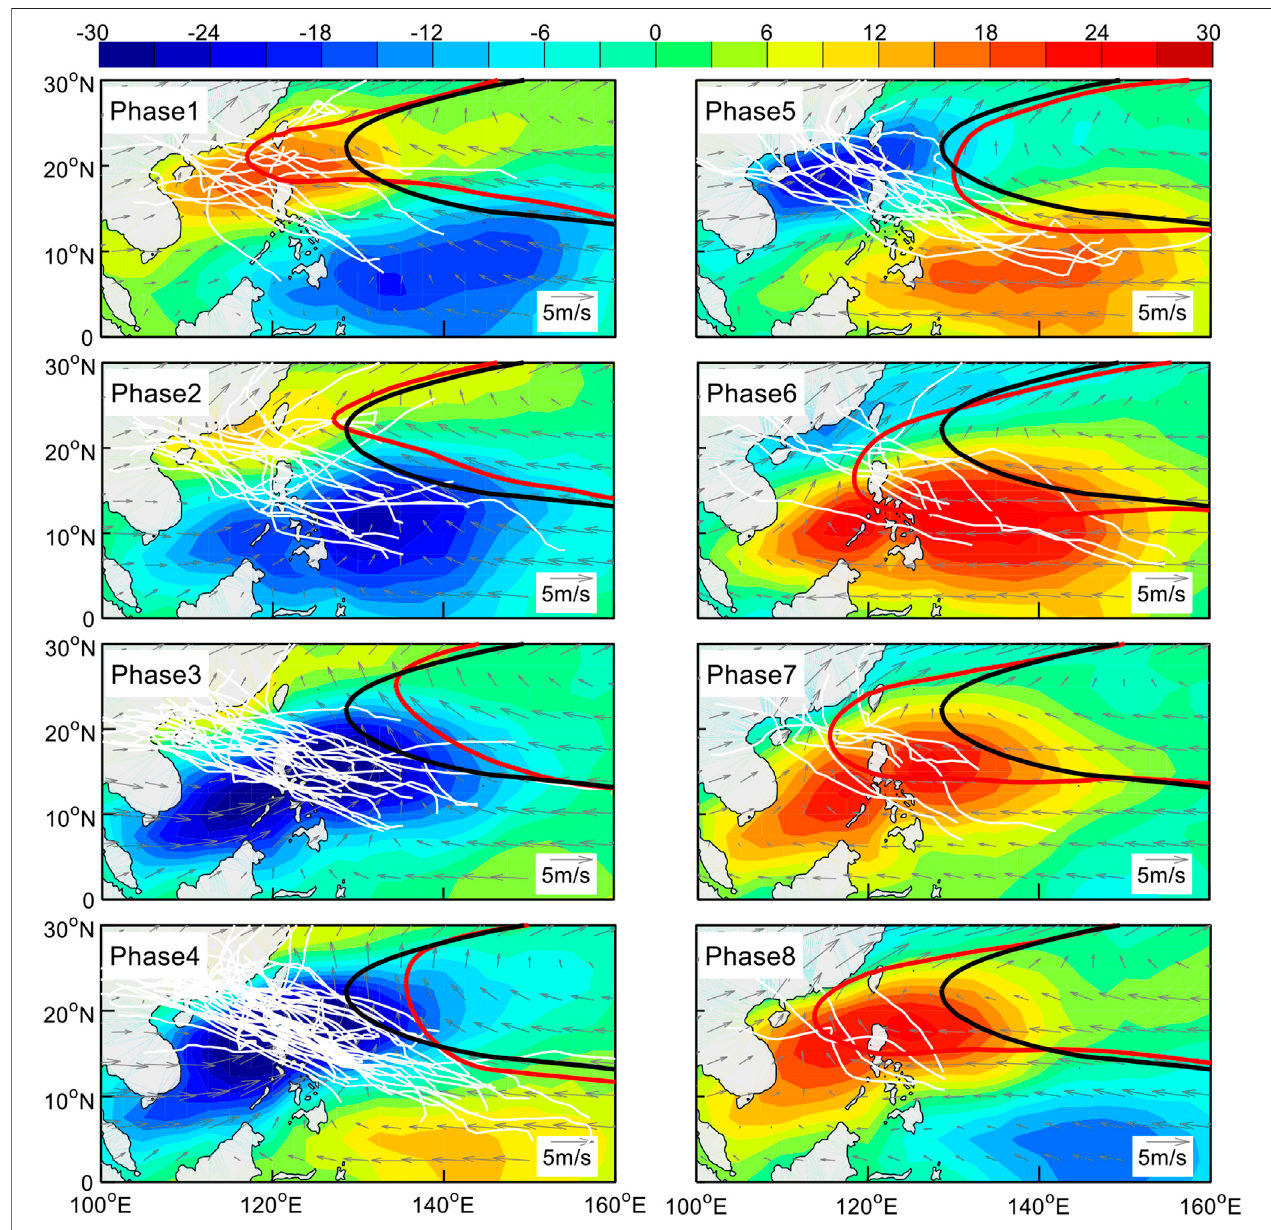
FIGURE 2 | The same as in Figure 1 but for each phase of